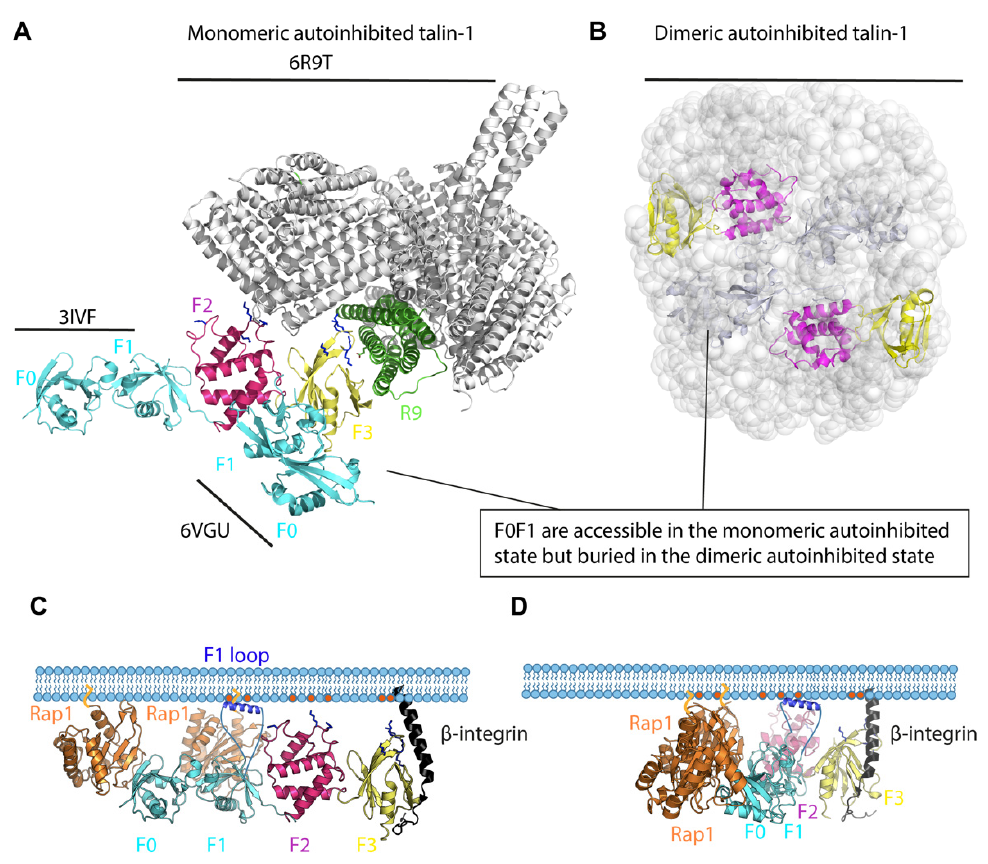
Figure 1. Talin autoinhibition and activation. ( A ). Monomeric autoinhibited talin-1. The F0-F1 subdomains of the linear (PDB: 3IVF) or cloverleaf (PDB: 6VGU) talin FERM domain structures are superimposed onto the monomeric cryo-EM talin structure (PDB: 6R9T, grey). The subdomain interaction between the FERM domain and the rod domain, mainly F3 (yellow)–R9 (green), is critical for autoinhibition. F0-F1 subdomains, cyan; F2, magenta. ( B ). Dimeric autoinhibited talin-1. Talin-1 forms a compact autoinhibited conformation in which the talin rods form a donut-shaped structure and the two FERM domains (F0, F1, F2, F3) are packed in parallel and buried in the donut hole. F0-F1 subdomains, cyan; F2, magenta and F3, yellow. ( C ). Integrin–talin head–Rap1–plasma membrane complex. In the linear conformation shown here, the talin F0 and F1 (cyan) interact with two Rap1 molecules (orange), which are bound to the plasma membrane through their C-terminal geranyl- geranyl moieties. The F1 loop (dark blue) and positively charged patches in F2 and F3 interact with the negatively charged PIP2 phospholipids (red) in the membrane. ( D ). A model of integrin–talin head–Rap1–plasma membrane complex based on the cloverleaf talin-1 FERM domain. It is not known whether the linear and cloverleaf conformations exist exclusively, in parallel, or sequentially (see text for